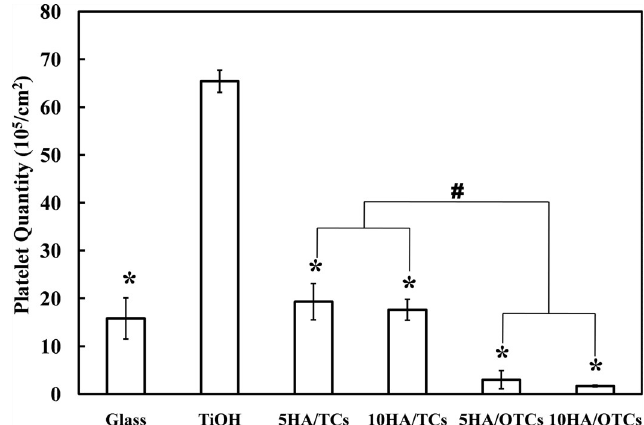
Figure 7. Quantitative analysis of the platelets adhered on the different substrates. * indicates a significant difference ( p < 0.001, one-way ANOVA) between the TiOH sample and the other five samples. # indicates a significant difference ( p < 0.001, one-way ANOVA) between the HA/QTCs samples and the HA/TCs samples.